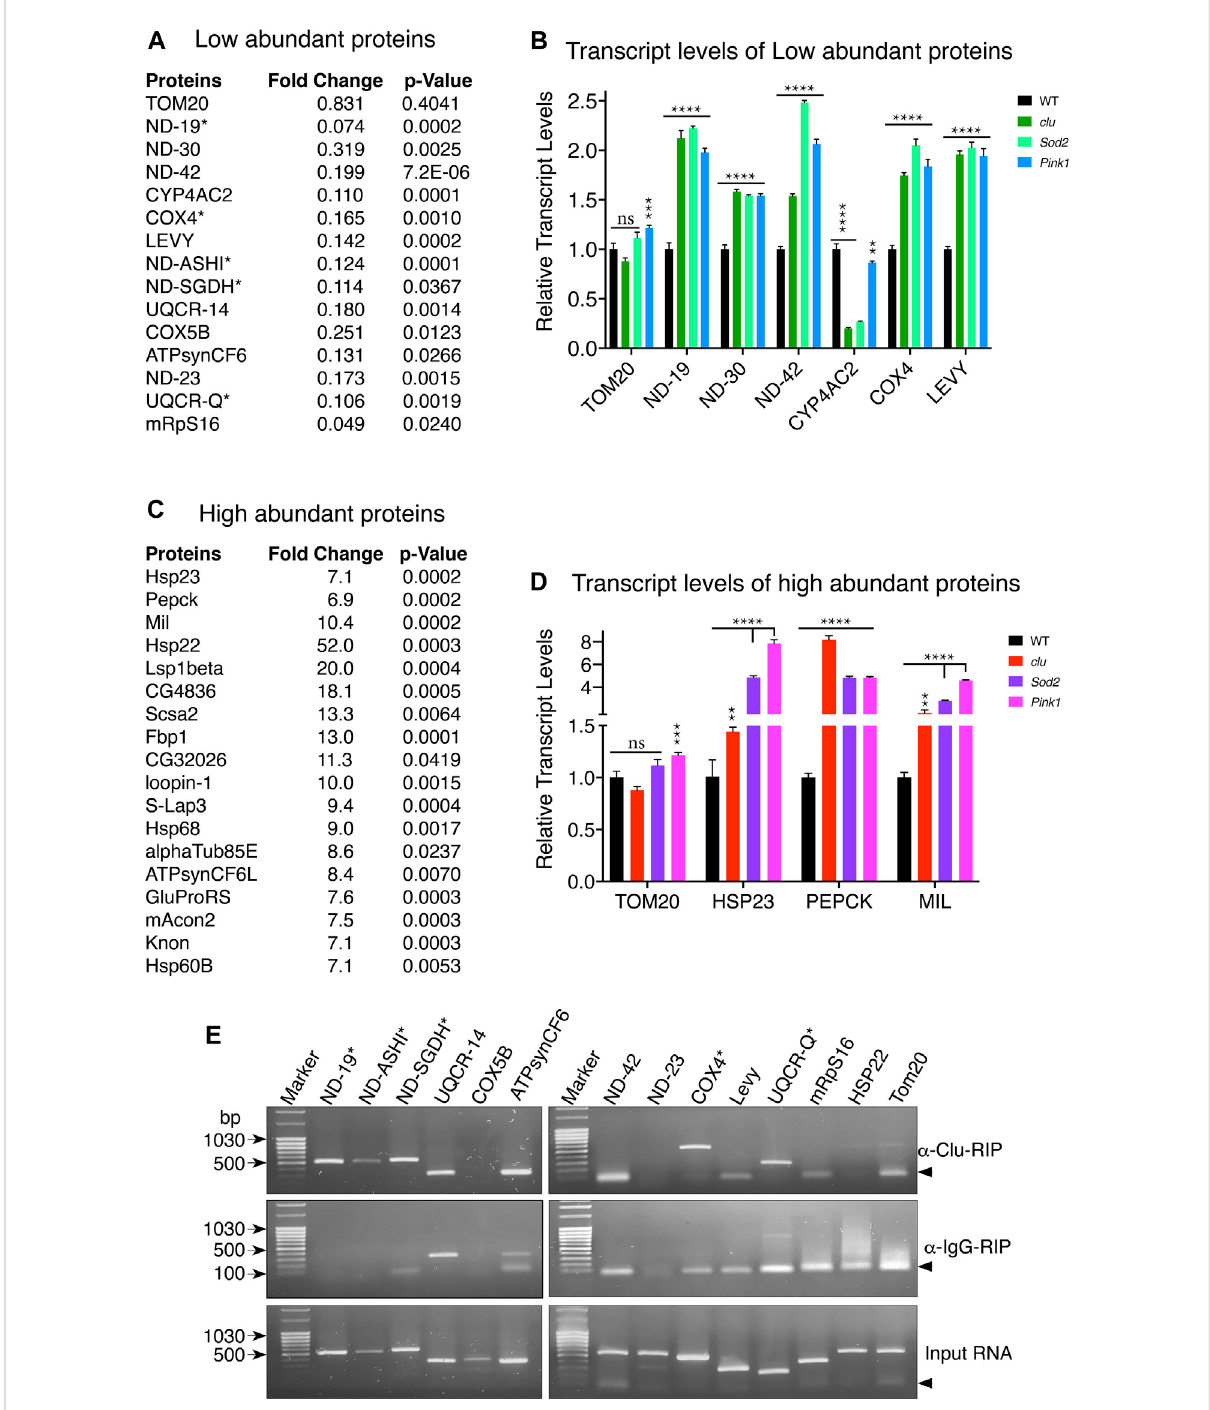
Loss of clu , Sod2 , and Pink1 increase transcript levels for candidate mitochondrial proteins. (A,C) Representative mitochondrial proteins with respectivefoldchangesand p valuesforless (A) andmore (C) abundantproteinsin clu mutants.Thetranscriptsofproteinsmarkedwithasterisksbind Clu. (B,D) Bargraphsshowingtherelativetranscriptlevelsofselectedless (B) andmore (D) abundantproteinsin clu , Sod2 ,and Pink1 mutants. (E) RT- PCRafterCluimmunoprecipitation(RIP).anti-IgGandinputarethetwocontrols.CandidatesmarkedwithasterisksbindClu.Arrowheadsshow the location of nonspeci fi c primer-primer dimers. (B,D) Error bars: S.E.M. calculated in GraphPad-PRISM software. p -values were calculated in GraphPad-PRISM software using an unpaired t -test and each mutant was compared to the wildtype control. Statistical signi fi cance = p <